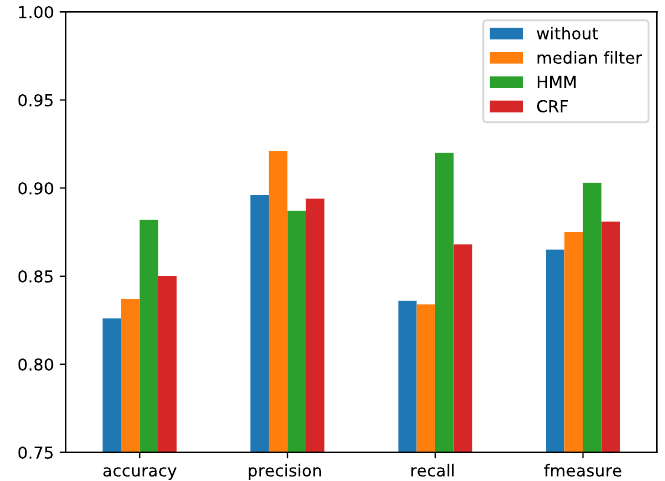
Figure 18. The comparison of different temporal smoothing methods as post-processing on the RWC